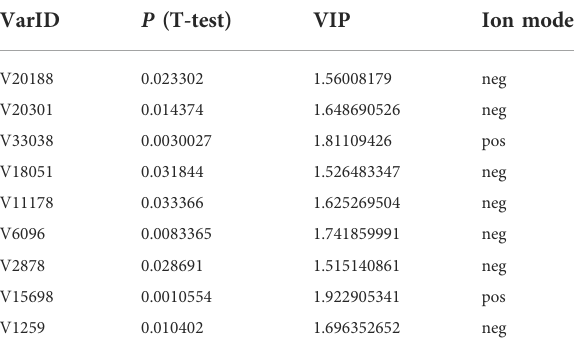
TABLE3ScreeningofthepotentiallyactivecomponentsofAGagainst heart failure.